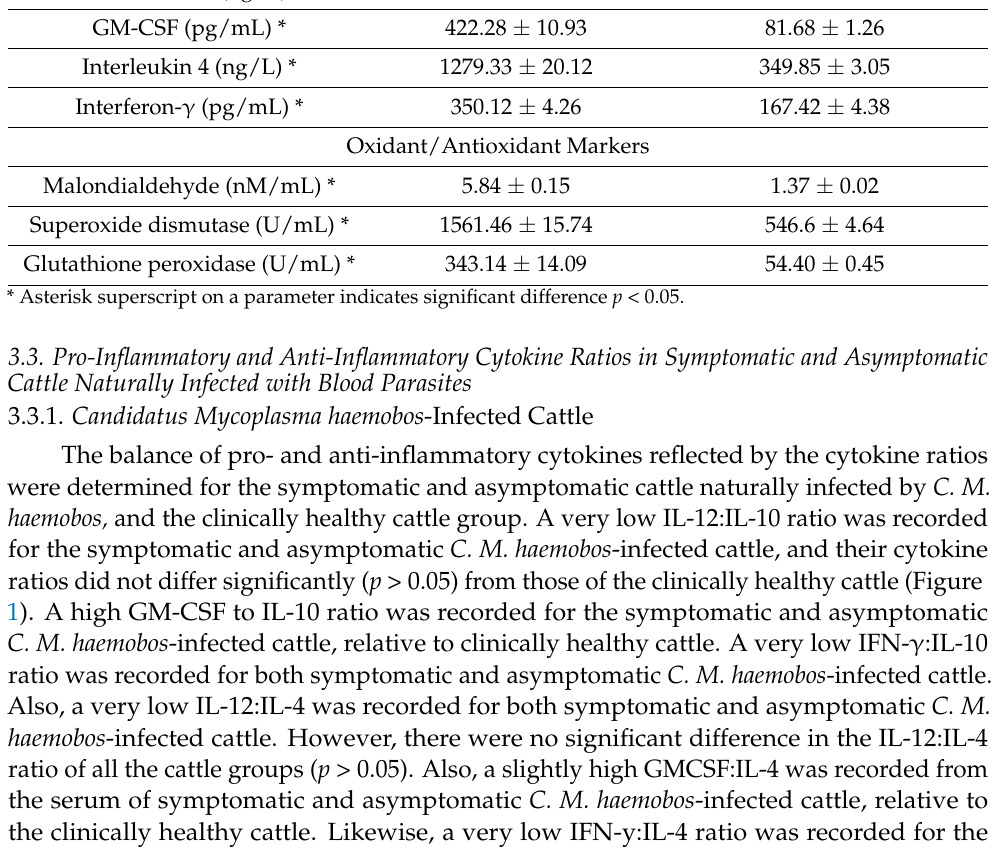
Table 8. The serum inflammatory cytokine and oxidant/antioxidant levels in symptomatic and asymptomatic cattle in cattle naturally infected by Anaplasma platys . Anaplasma platys Proinflammatory/ Infected Cattle Anti-Inflammatory (Symptomatic) Cytokines ( n =